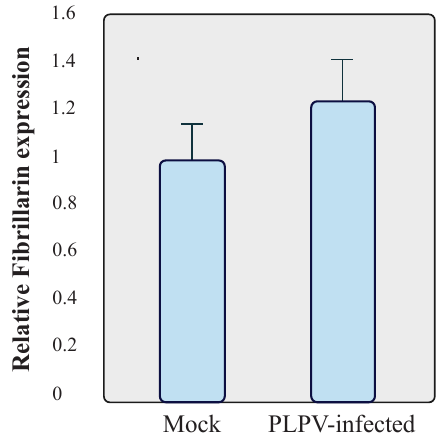
Figure 7. Assessment of mRNA fibrillarin levels. Total RNA preparations were obtained from mock and PLPV-infected wt N. benthamiana plants and subjected to RT-qPCR to estimate relative levels of fibrillarin transcripts. The bars depict the standard deviation from three independent biological replicates. The statistical significance was evaluated using a paired t -test (no significant differences were detected).